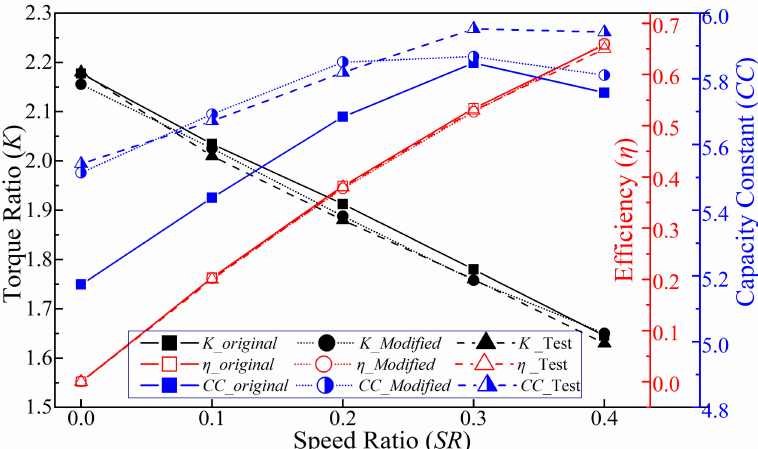
Figure 37. Comparison of torque ratio, efficiency, and capacity constant between the original model and modified model and test at various speed ratios under cavitating conditions.